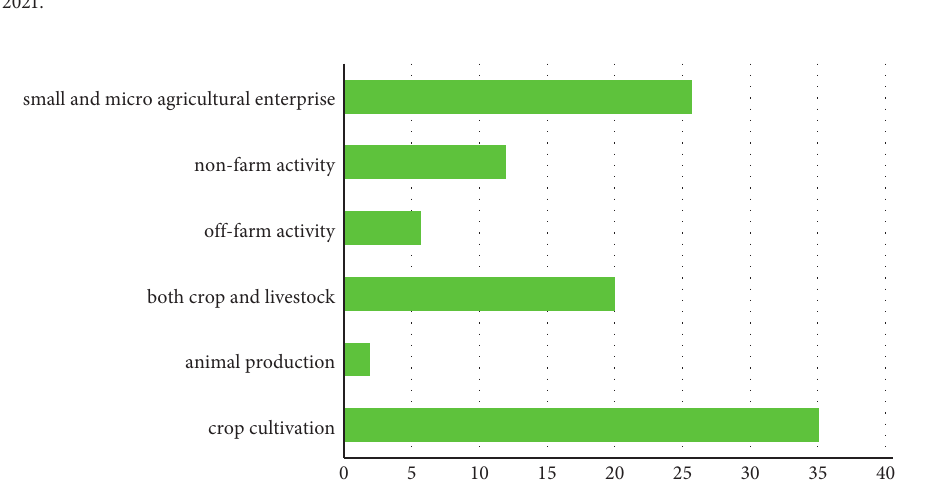
Figure 1: Livelihood sources